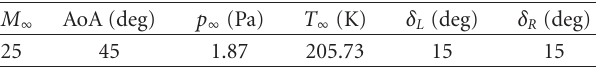
Table 1: IXV reentry vehicle: free-stream flow conditions and flap deflection